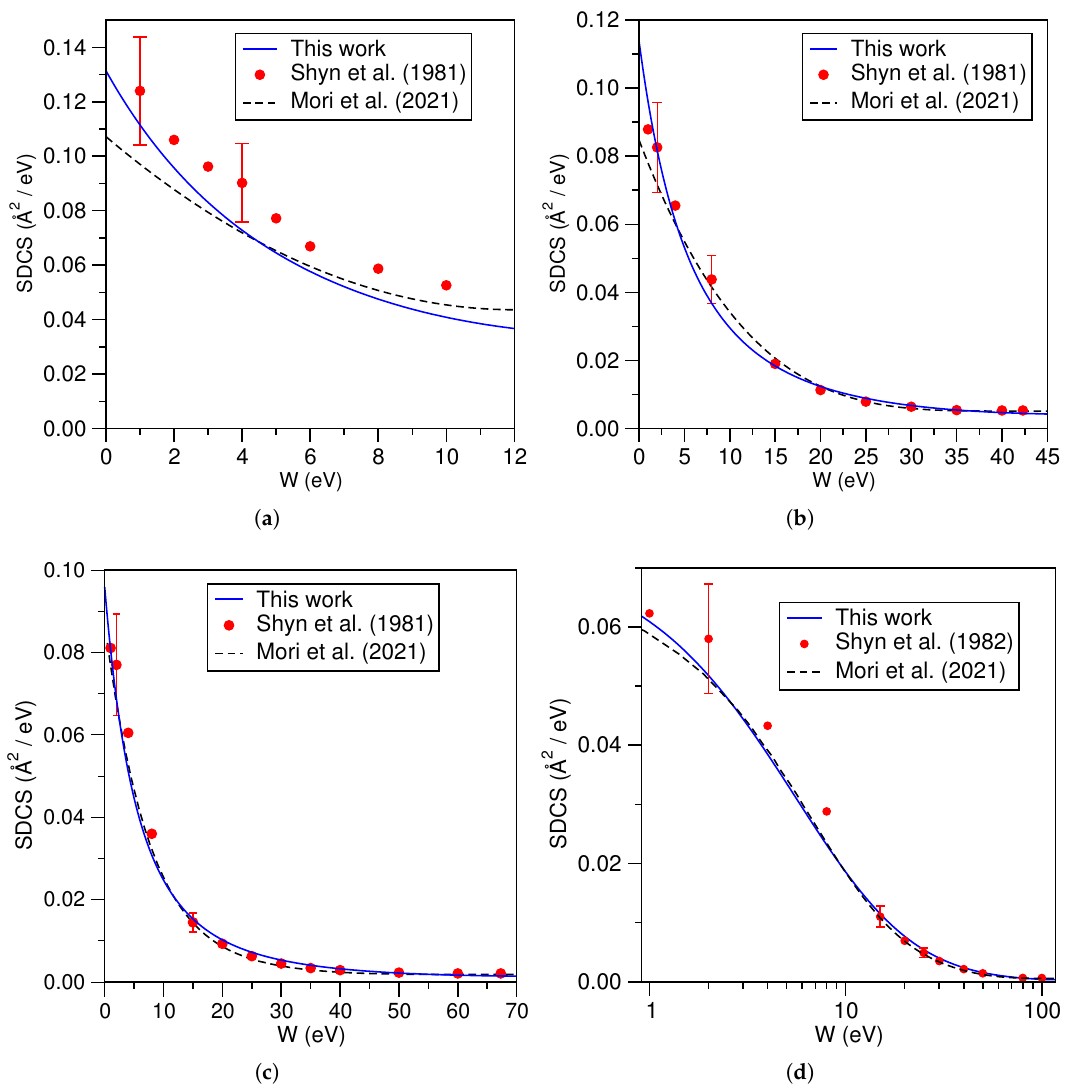
Figure 3. Electron-impact SDCS for H 2 at a primary electron energy of ( a ) T = 40 eV, ( b ) T = 100 eV, ( c ) T = 150 eV, and ( d ) T = 250 eV. The solid lines represent the present results, the dashed lines are the results of Mori et al. [33], and the filled circles are the experimental measurements of Shyn et al.